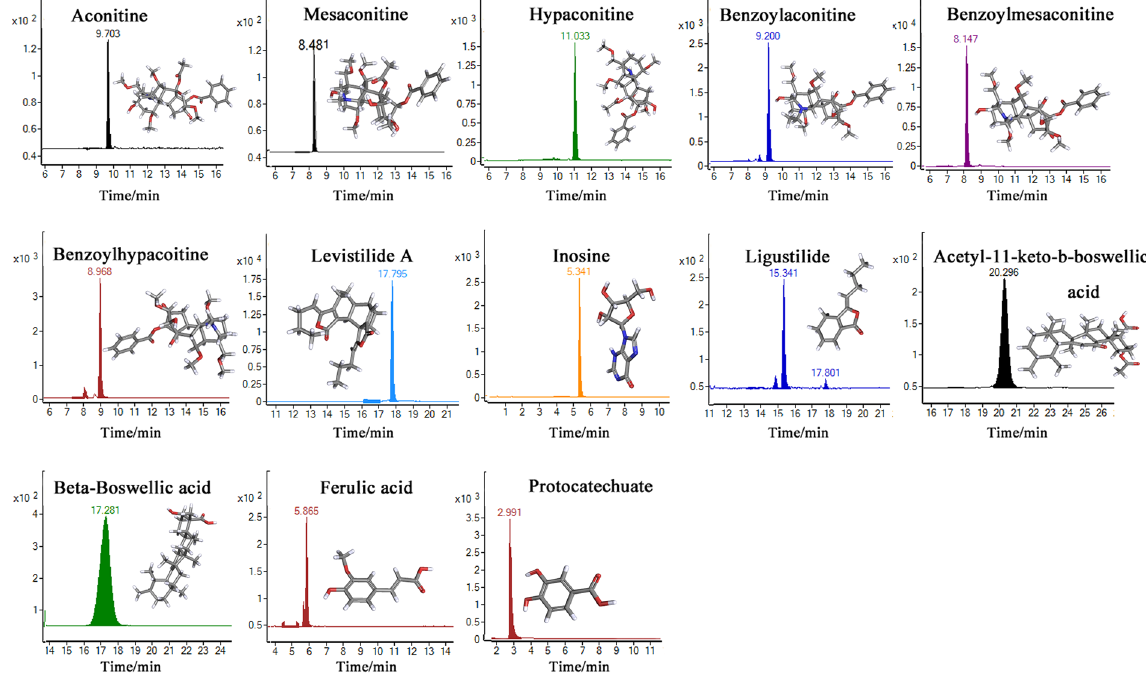
Figure 5. Typical MRM and chemical structures of the 13 compounds in Xiaojin